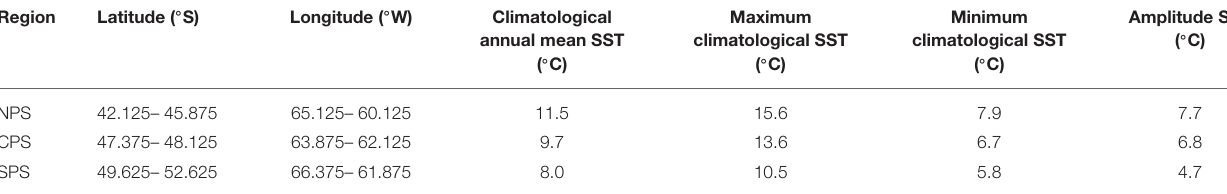
TABLE 3 | Basic statistics of Sea Surface Temperature for the regions NPS, CPS, and SPS.